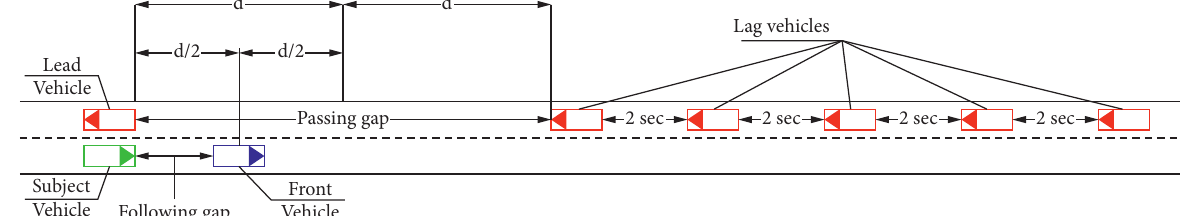
Figure 2: Passing gap configuration. Table 1: Characteristics of the analysis configurations. Passing gap Configuration Traffic condition